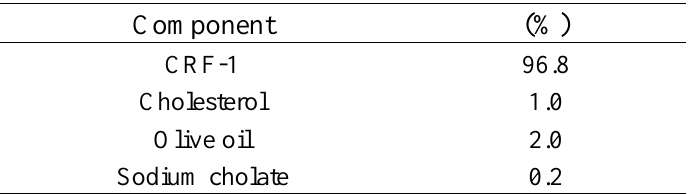
Table 1: Composition of